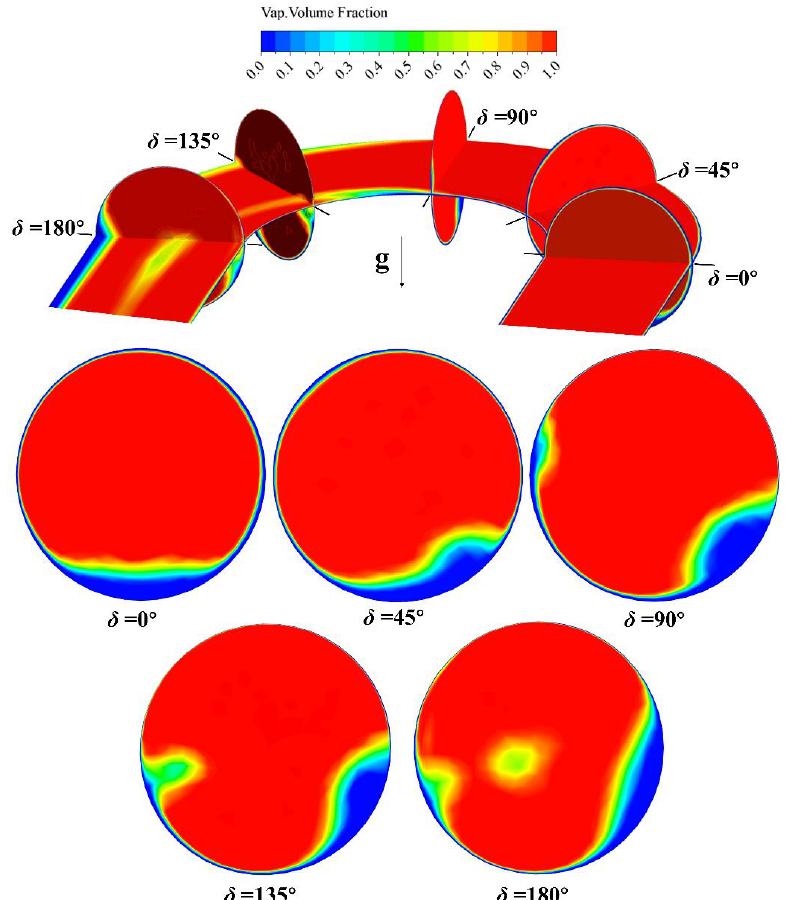
Figure 10. Distribution of volume fraction of vapor phase in the U-bend section under G = 300 kg/(m 2 ·s) in HUB tube.